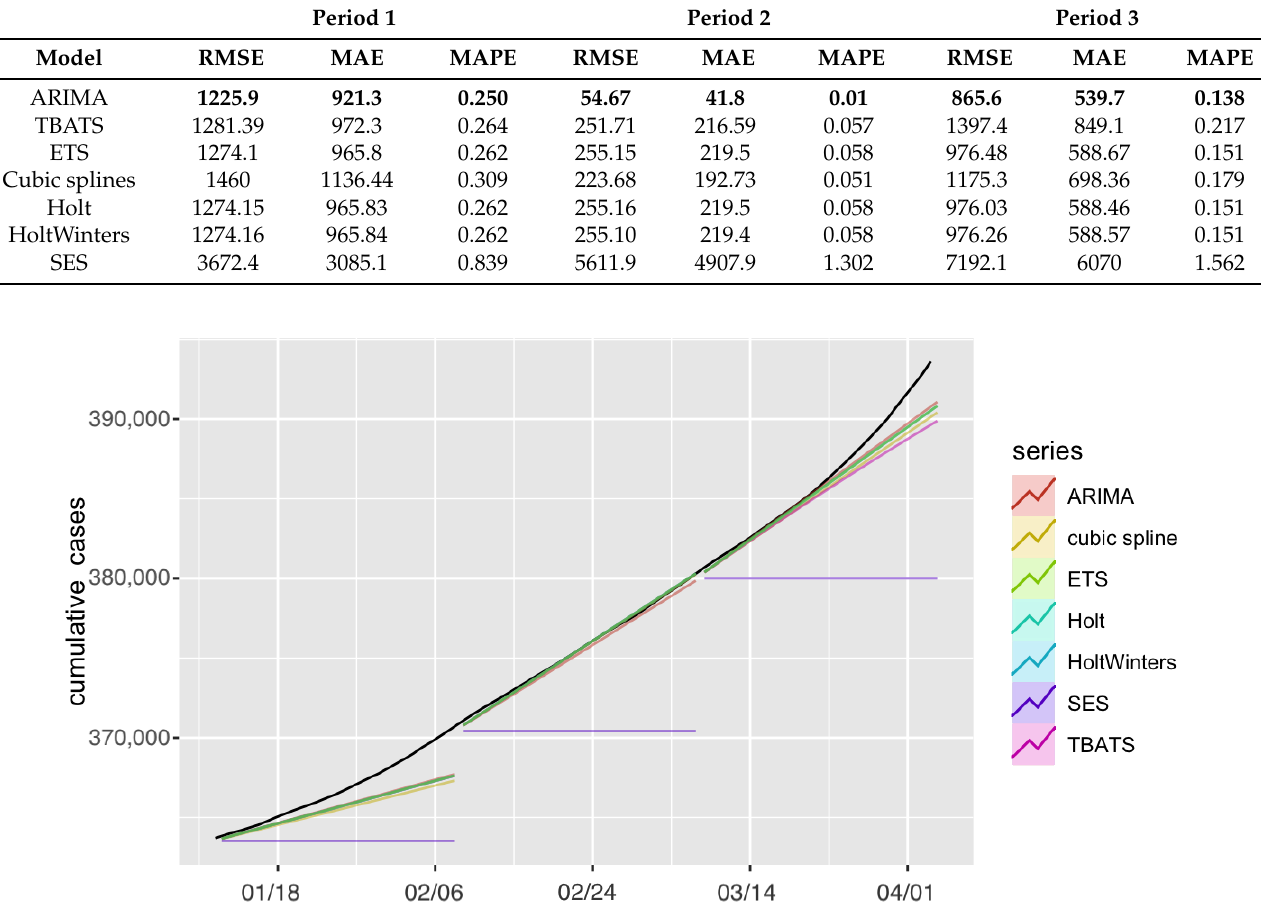
Table 3. Performance of the proposed models to predict confirmed KSA cases. The best accuracy values are shown in bold.